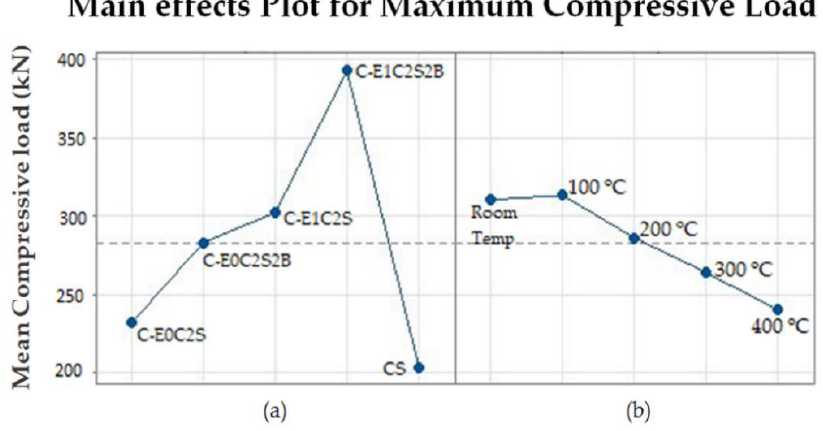
Figure 13. Main effects plot for maximum compressive load of specimens ( a ) Type of confinement ( b ) Exposure temperature.